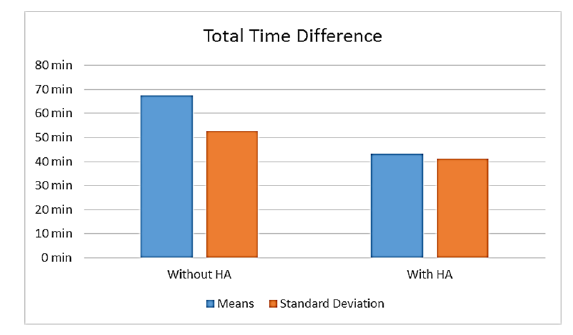
Fig. 3: Means and Standard Deviation for Time